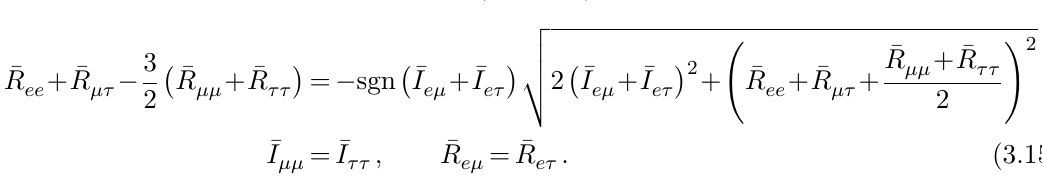
Figure 3 . sin 2 (cid:27)= sin 2 (cid:26) as a function of the lightest neutrino mass ( m the IH case) in the case of two sides of equations C and F being